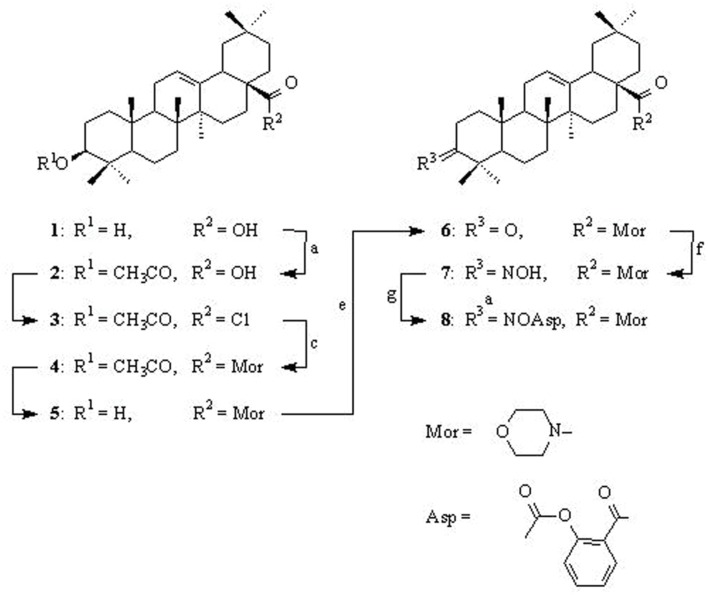
Synthesis of conjugate OAO-ASA (8). Reagents and conditions: (a) pyridine, (CH3CO)2O, rt.; (b) SOCl2, rt.; (c) C6H6, morpholine, rt.; (d) C2H5OH, KOH, reflux; (e) acetone, Jones reagent, rt.; (f) C2H5OH, NH2OH x HCl, CH3COONa, reflux; (g) dioxane, ASA, DCC, rt.